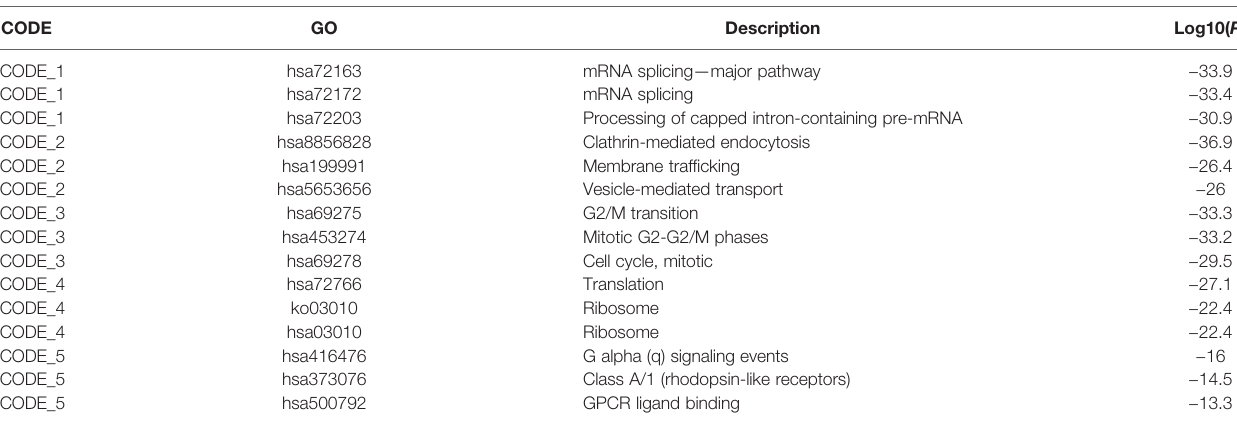
TABLE 1 | MCODE enrichment analysis in AD.